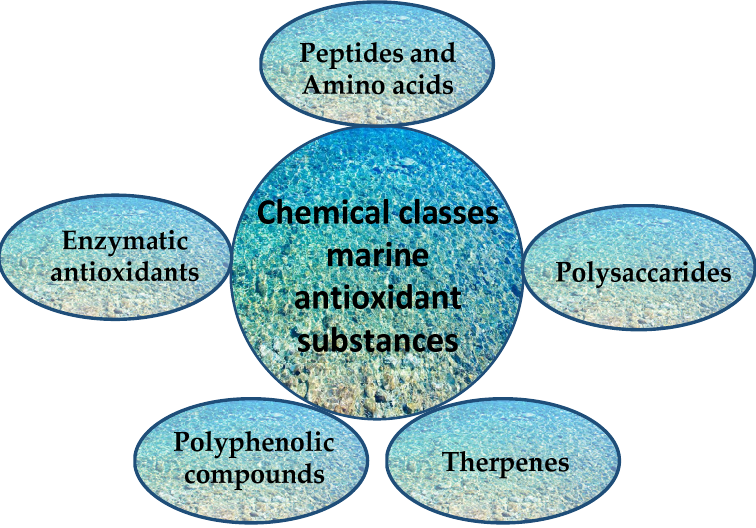
Figure 5. Main chemical classes of antioxidant substances derived from marine sources.